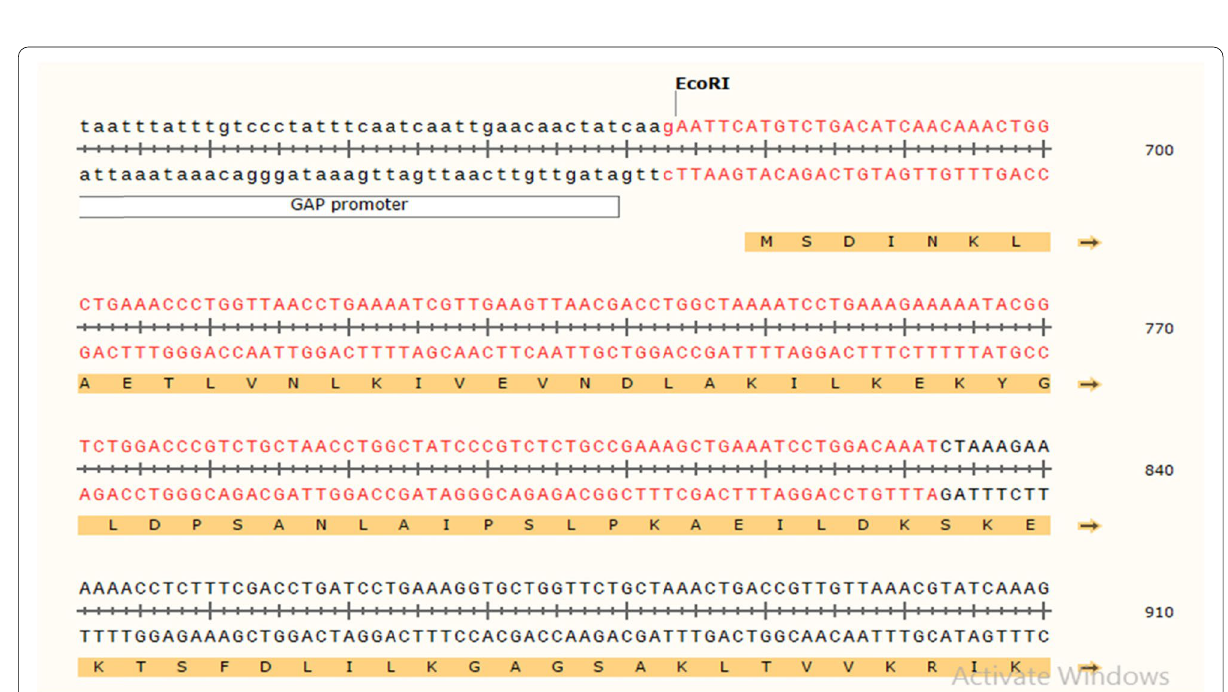
Fig. 14 The sequence of the constructed vaccine in the plasmid